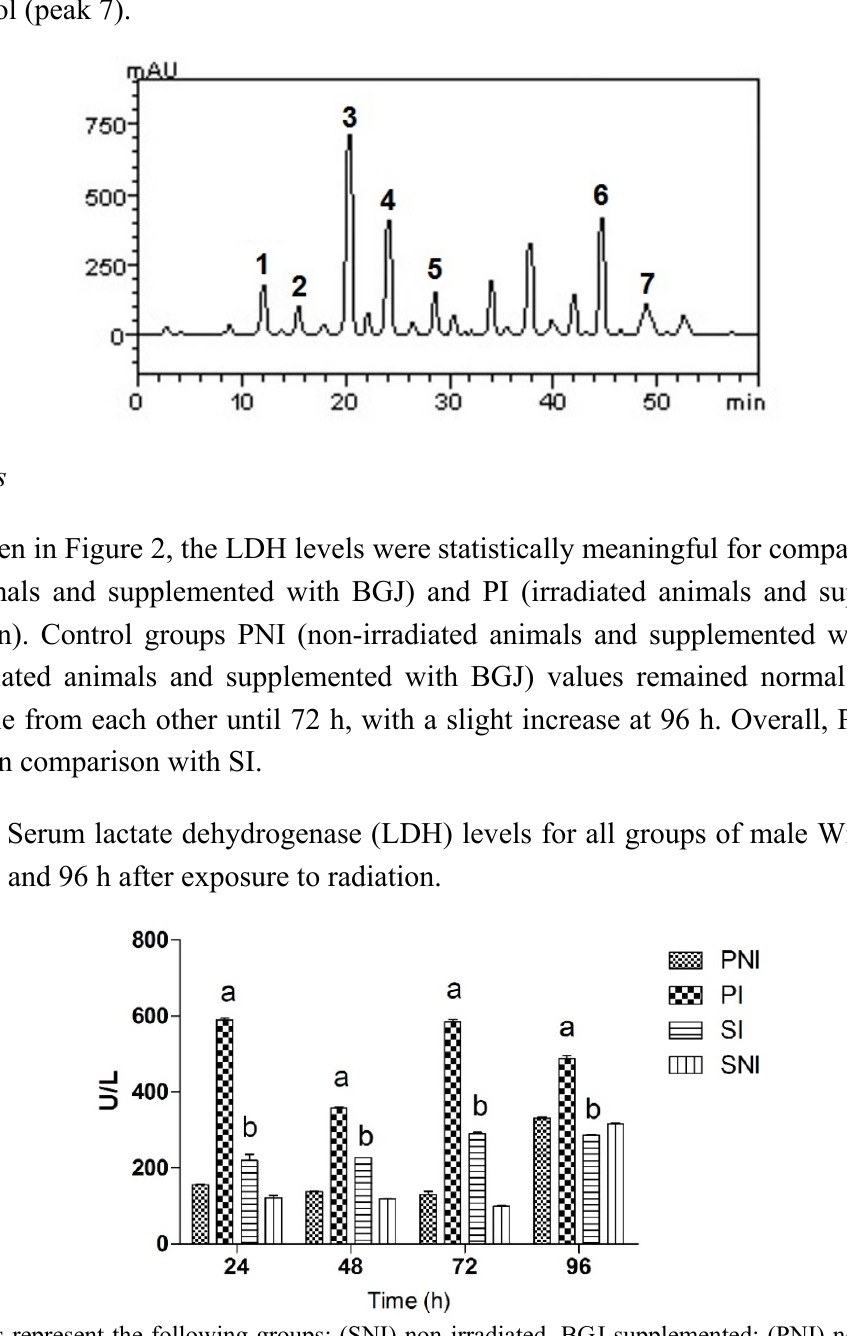
Figure 1. Representative high performance liquid chromatography (HPLC-DAD) profile of BGJ, detection UV was set at 327 nm. Gallic acid (peak 1), catechin (peak 2), resveratrol (peak 3), caffeic acid (peak 4), ellagic acid (peak 5), quercetin (peak 6) and kaempferol (peak 7).